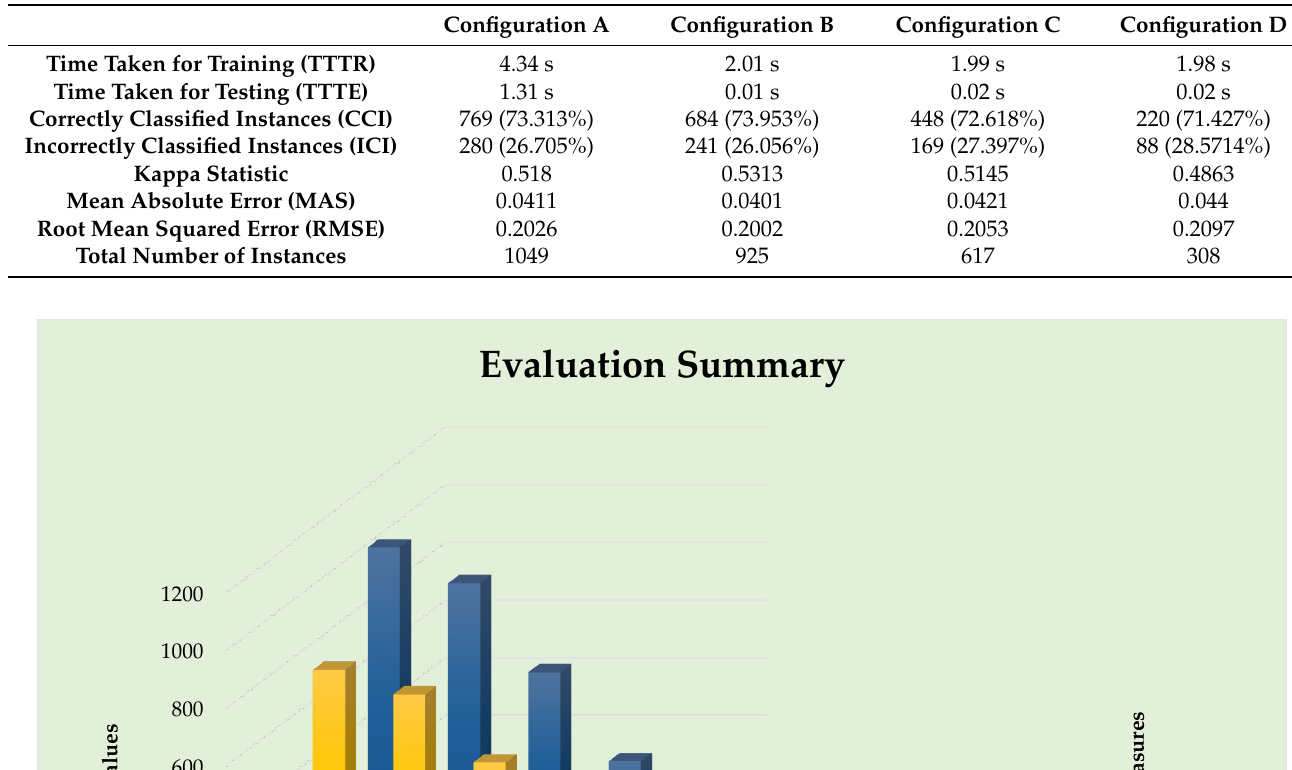
Table 3. Evaluation of test split (single feature selection technique).